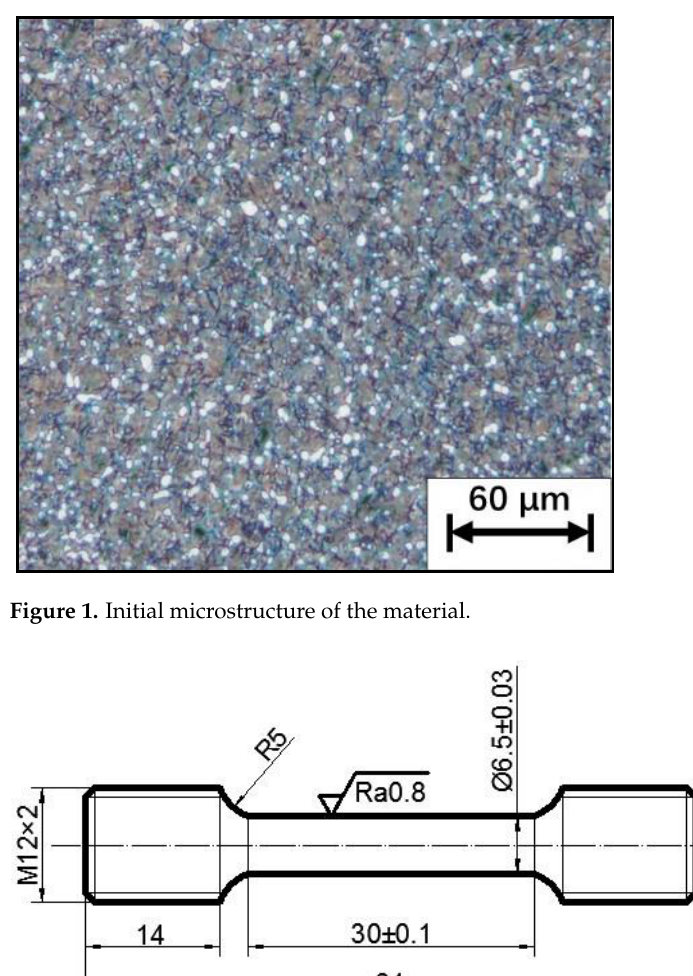
Figure 1. Initial microstructure of the material.